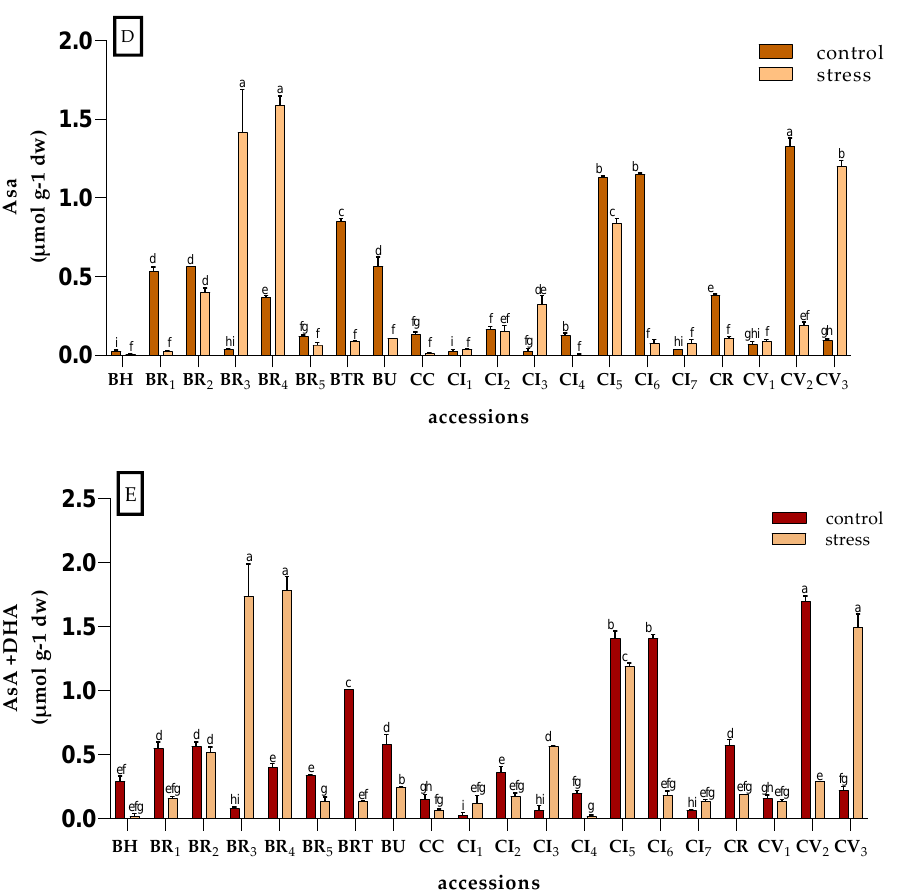
Figure 2. Influence of genotype and drought treatment on the antioxidant compounds in the 20 accessions studied. ( A ) Total phenolic compounds (TPC); ( B ) Reduced Glutathione (GSH); ( C ) Oxidized glutathione (GSSG); ( D ) Reduced Ascorbic acid (AsA); ( E ) Total ascorbic (AsA + DHA). Data are reported as mean ± S.E. Different letters indicate significant differences among accessions undergoing the same treatment according to Tukey test ( p < 0.05).